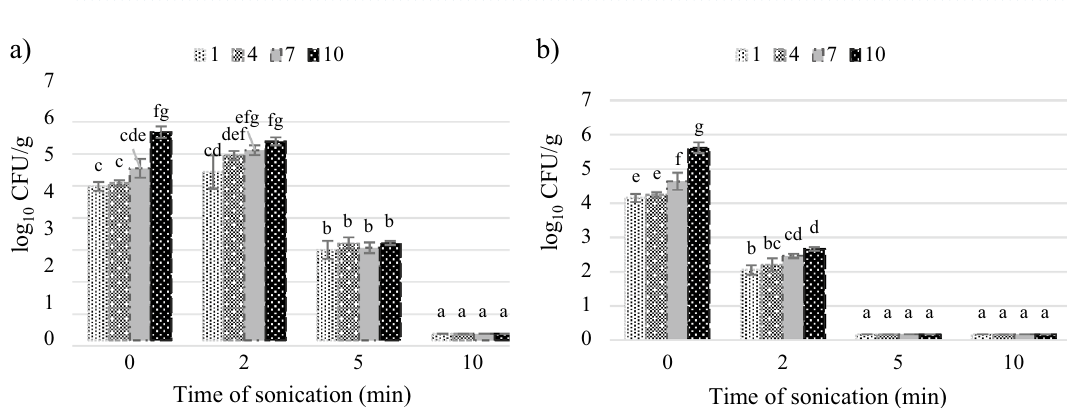
Figure 1. Effect of ultrasound intensity and sonication time on the total aerobic mesophilic bacteria count: ( a ) intensity 28 W cm −2 , ( b ) intensity 40 W cm −2 .